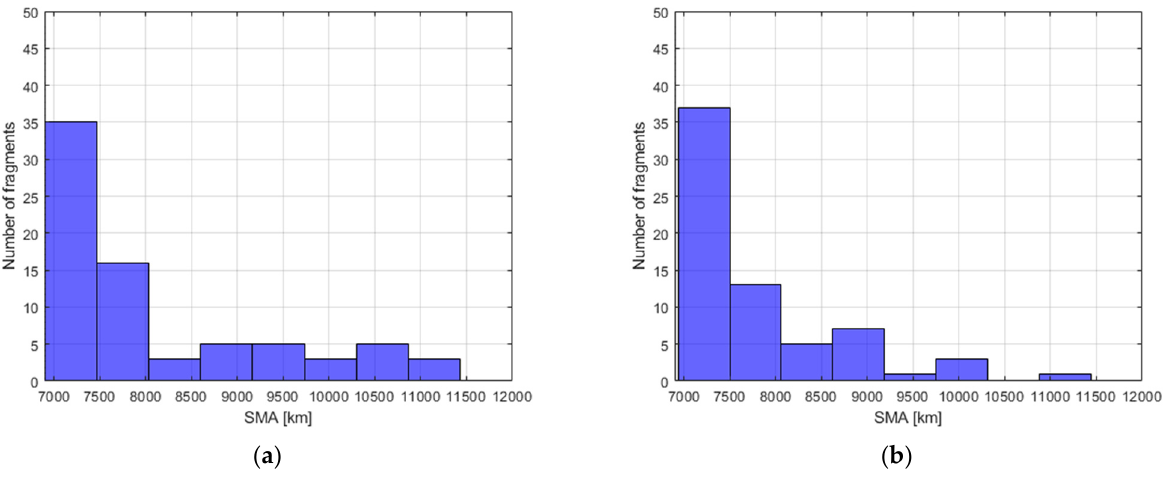
Figure 14. Histograms of reference ( a ) and estimated ( b ) fragments in range [80°, 100°] of inclination for second test case.